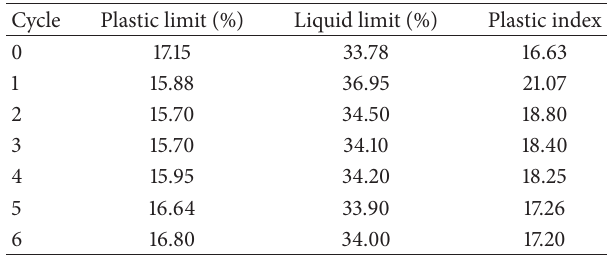
Table 2: Results of the liquid and plastic limits under different wet- dry cycles. Cycle